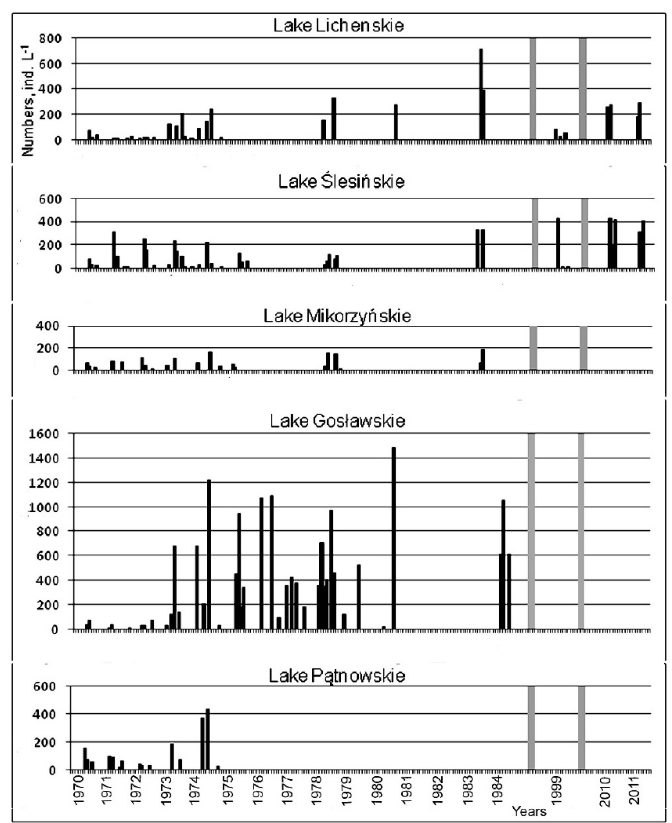
Figure 3. Results of long-term extensive observations of rotifer density in water column in the Konin lakes. Data for 1999 are derived from [41]. Grey lines indicate gaps in research for the years 1985–1998 and 2000–2009.